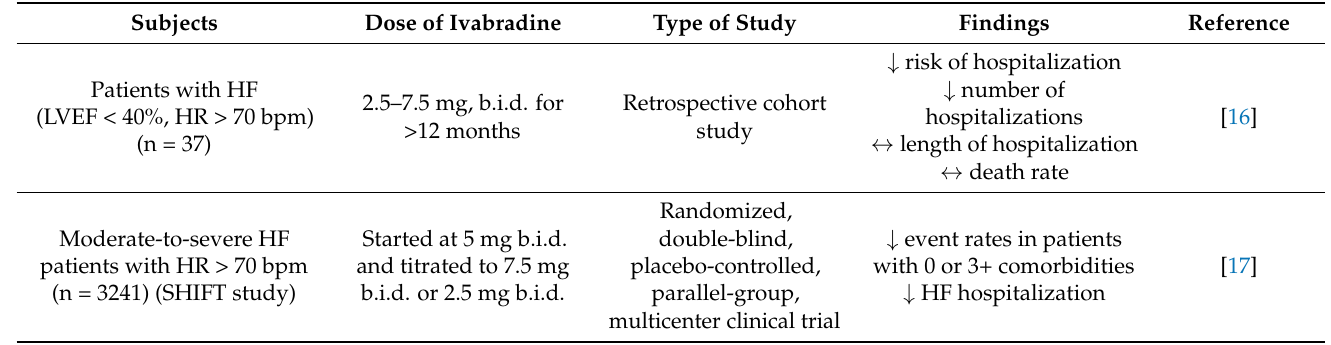
Table 1. Effects of ivabradine therapy on clinical outcomes in patients with heart failure.